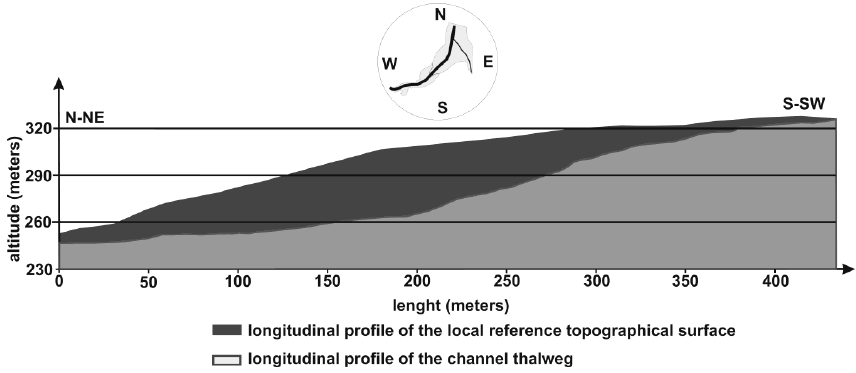
Fig. 10. Longitudinal profiles of surface and river bed of the main Cucuteni-Baiceni gullies 2010